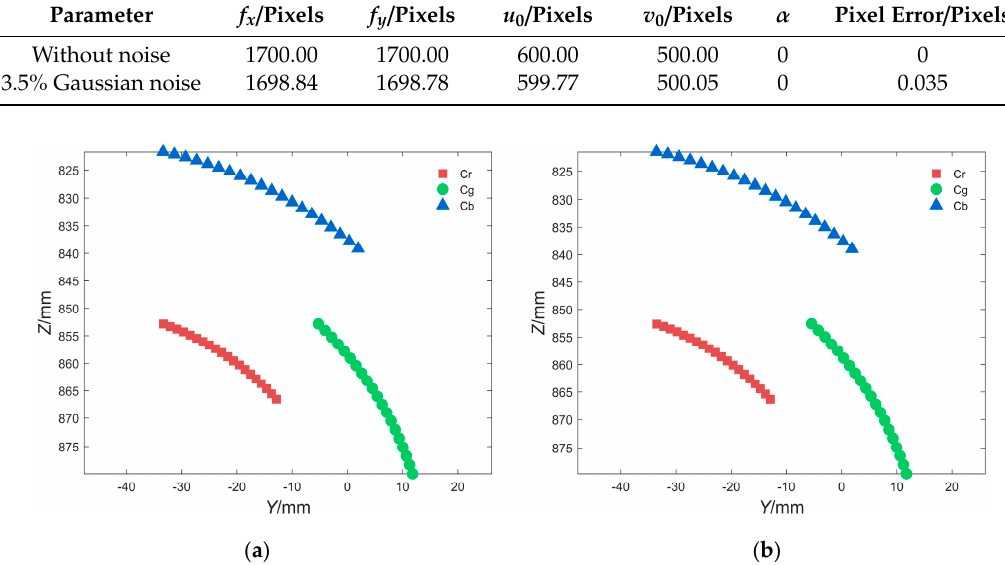
Figure 5. The rotation diagram of the simulated camera placed at positions Cr, Cg and Cb. Table 1. Simulated calibration results.